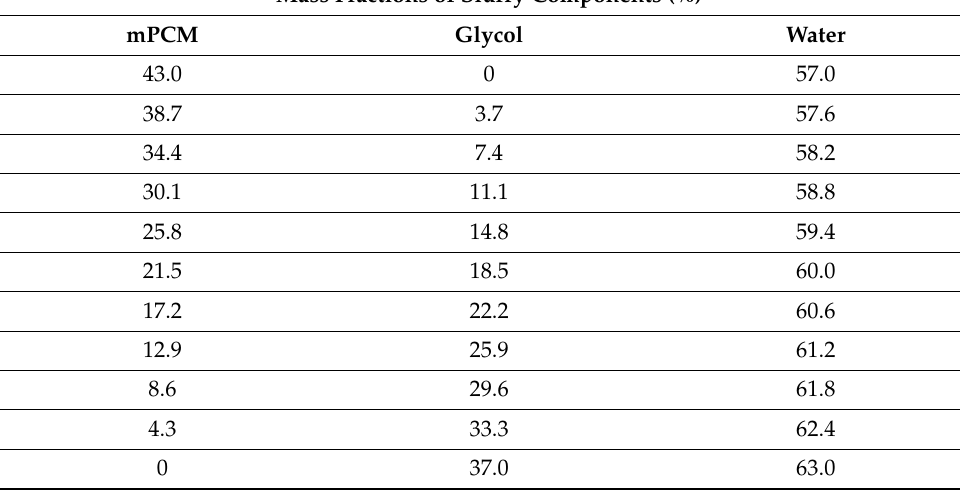
Table 1. Mass fractions of major components of mPCM slurry based on aqueous propylene glycol so-